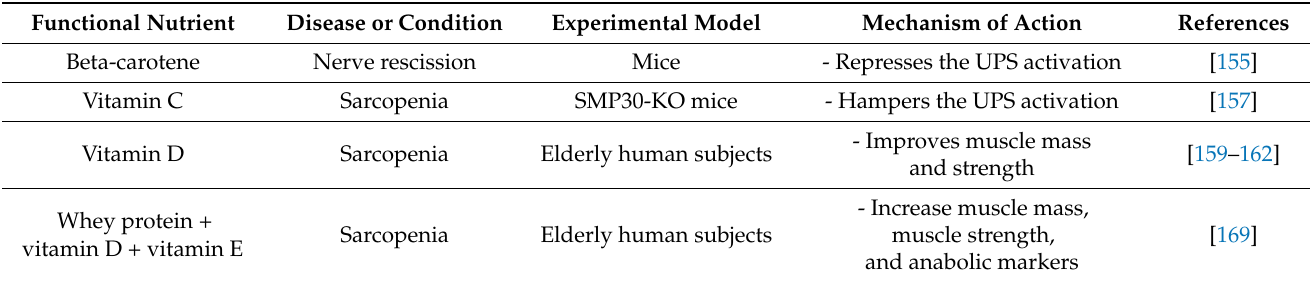
Table 3. Vitamins affecting neurogenic muscle